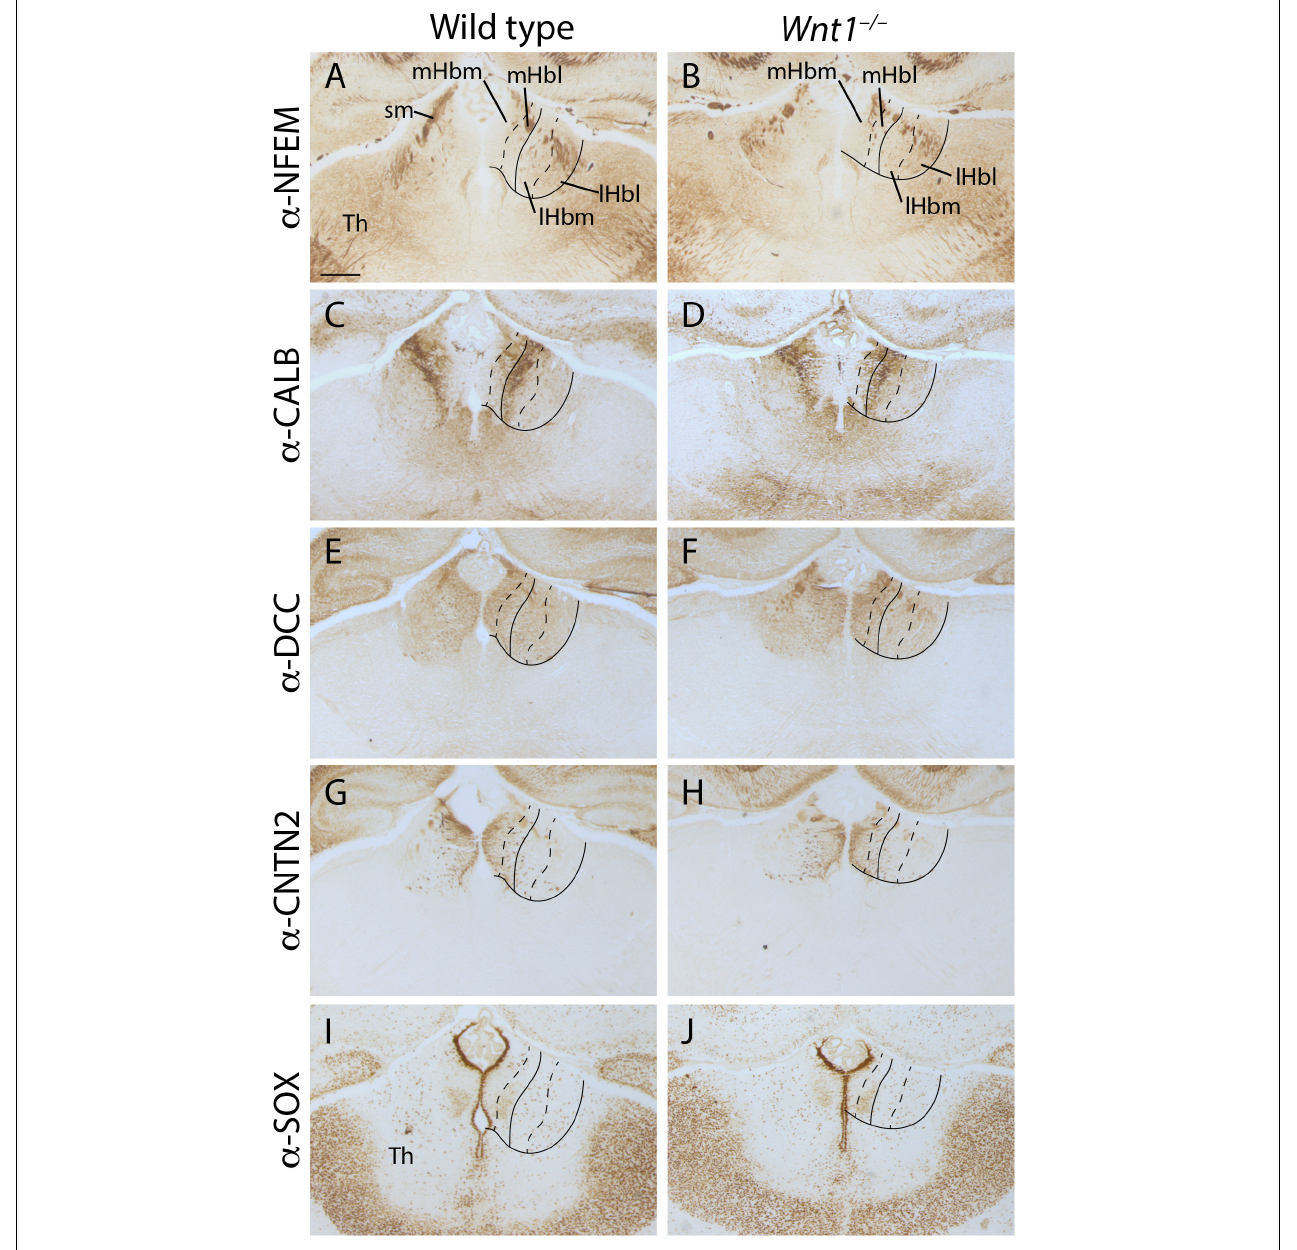
FIGURE 3 | Analysis of the habenular subnuclei organization. E18.5 wt (A,C,E,G,I) and E18.5 Wnt1 − / − (B,D,F,H,J) brain coronal sections. (A,B) labeled by immunohistochemistry against NFEM as lHb marker. (C,D) labeled against CALB, (E,F) DCC, (G,H) CNTN2 and (I,J) SOX1 as mHb markers. Four samples of each genotype have been analyzed. Th, thalamus; sm, stria medullaris; mHbm, medial division of the medial habenula; mHbl, lateral division of the medial habenula; lHbm, medial division of the lateral habenula; lHbl, lateral division of the lateral habenula. Scale bar: 200 µ